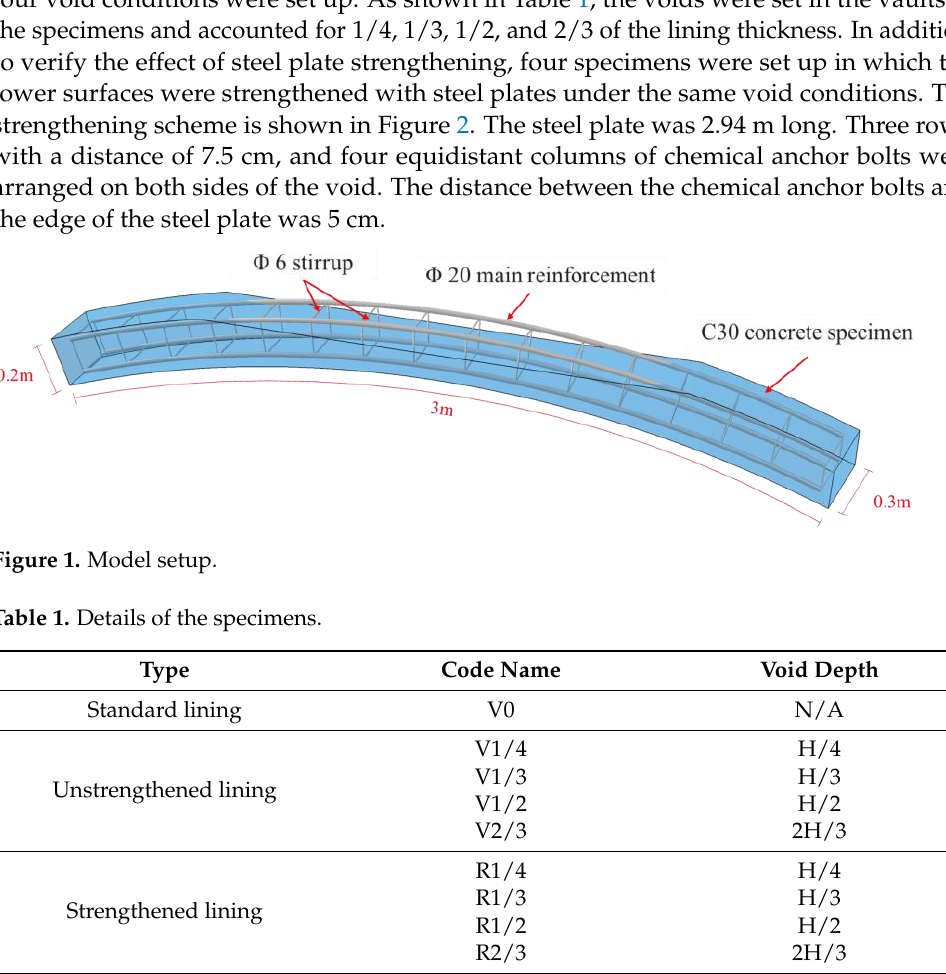
Figure 2. Steel plate strengthening scheme.